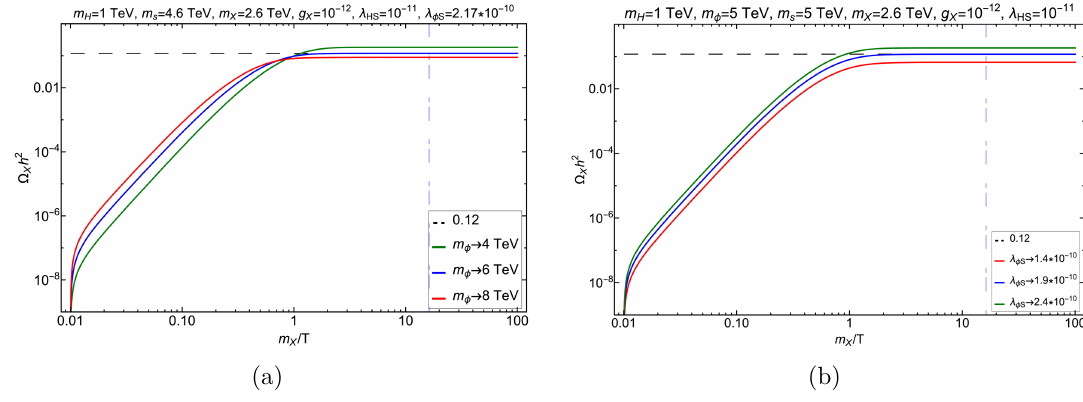
Figure 9 . Freeze-in production for X bEWSB in relic density ( Ω X h 2 ) versus x = m X kinematic region m s < 2 m X , when scattering processes contribute to DM production. Variation with respect to m φ (left) and λ φS (right) for three representative values that provide under, correct and over relic abundance are shown by red, blue, green lines. Horizontal black dashed line shows observed relic density. The vertical dot-dashed lines denote the boundary of EWSB. The parameters kept fixed are written in the figure insets as well as in the figure